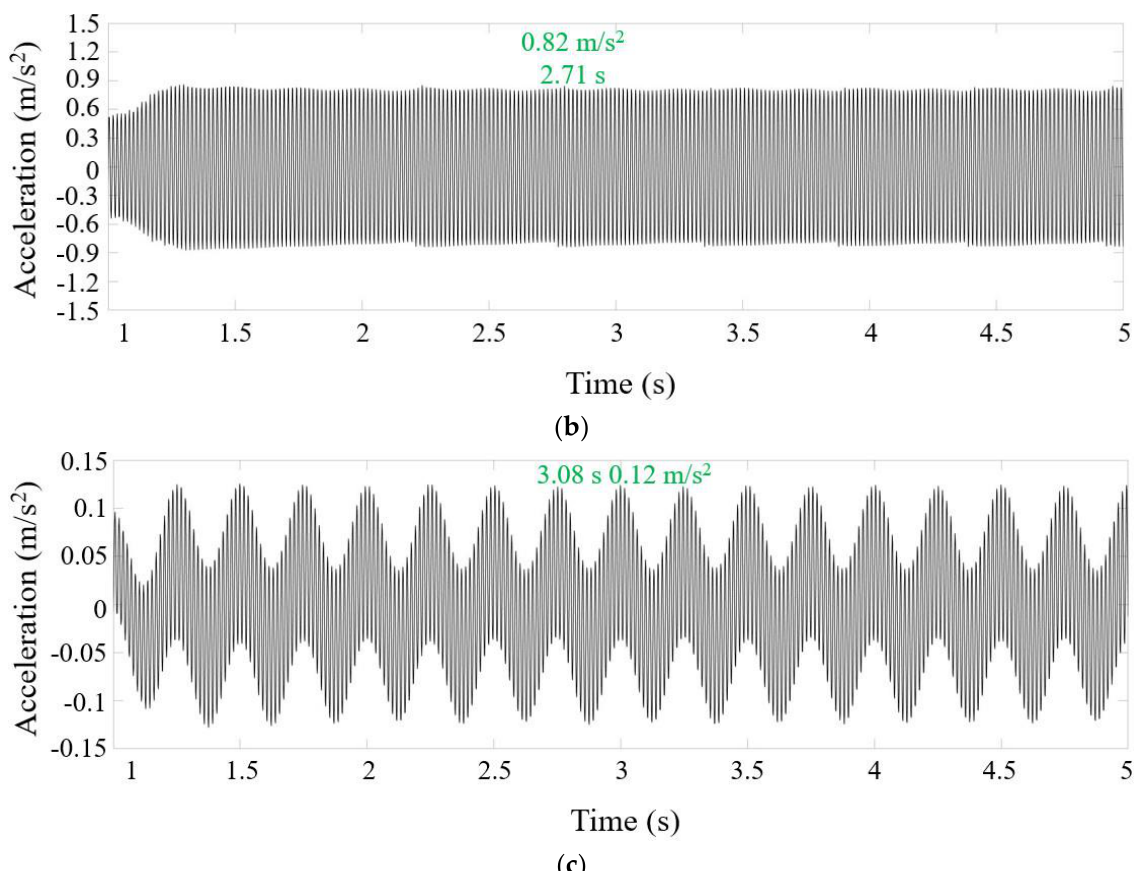
Figure 4. The vertical accelerations of the swing shaft ( a ), the lower die ( b ) and the frame ( c ). To verify the effectiveness of oscilloscope results, an acceleration test experiment of the COF machine is conducted, and the experiment instruments are shown in Figure 5.